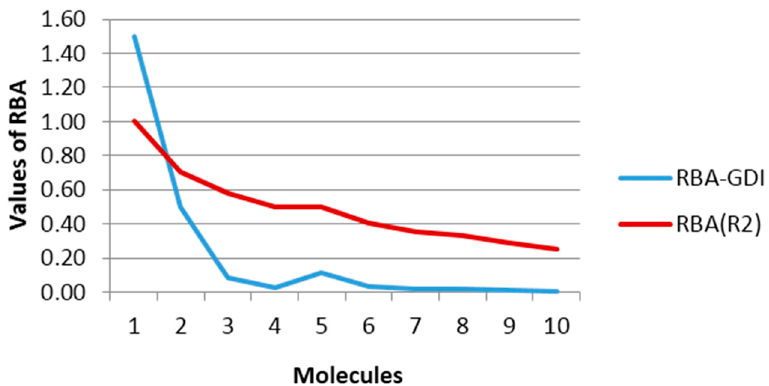
Figure 4. Graphical behavior of the steric reactivity based in LOVIs calculated by GDIs and the Relative Bond Accessibility Area (RBA) proposed by Estrada for evaluating the accessibility.